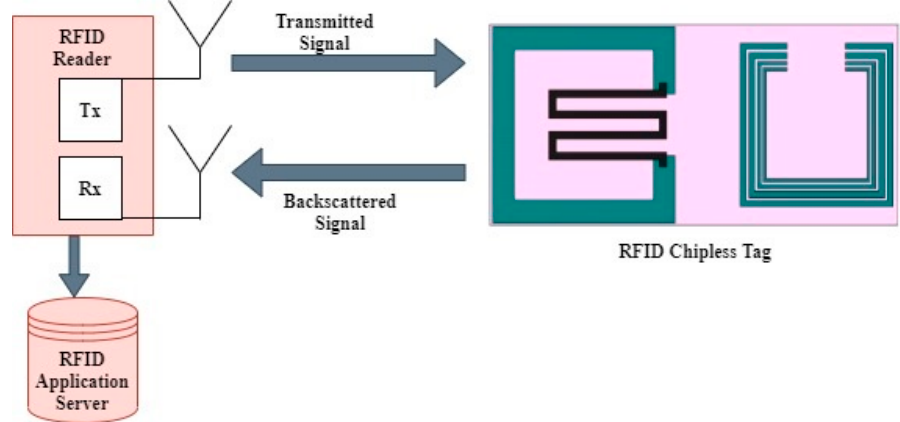
Figure 1. Proposed RFID Setup.